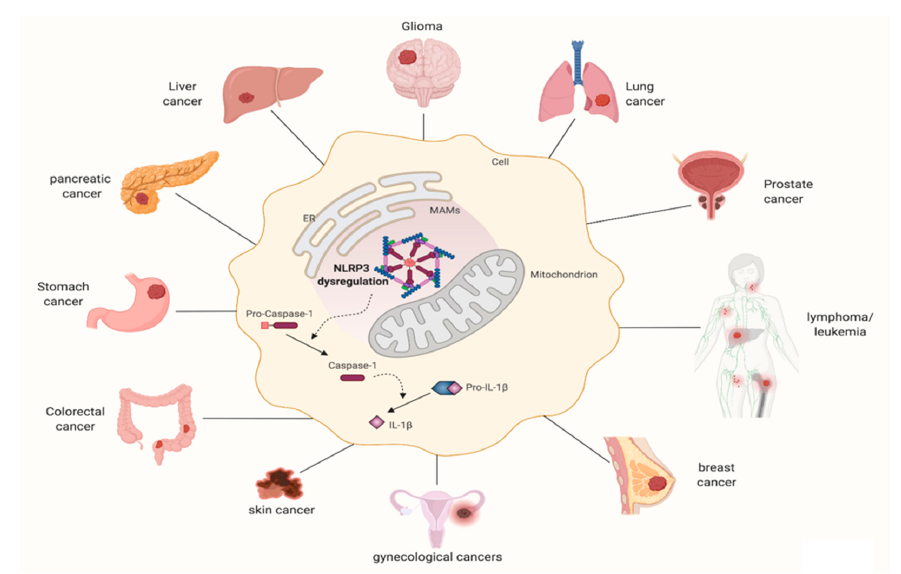
Figure 2. NLRP3 inflammasome involvement in distinct types of cancer.